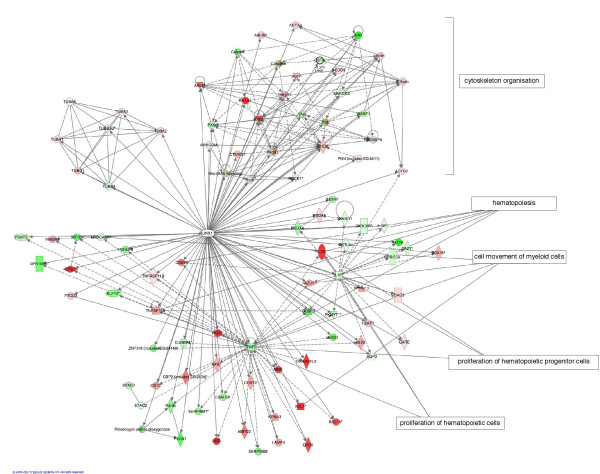
Part of the networks downsteam of RUNX1. Additional data from the literature and our studies were used to update the standard Ingenuity Pathway System (Ingenuity® Systems, ) network analyses. Genes up-regulated (red) or down-regulated (green) in either FPD or CBF are indicated. Selected chosen functions with significant network nodes are shown including all the genes involved in cytoskeleton organization. Grey arrows represent transcriptional regulation, grey lines represent direct interaction, dotted lines represent indirect link. Each kind of molecule is represented by a different symbol (see ).